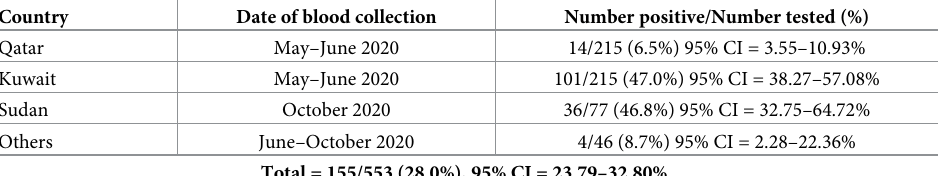
Table 4. Seroprevalence of anti-SARS-CoV-2 antibodies in Thai people returning from extended periods of work in high-risk countries.